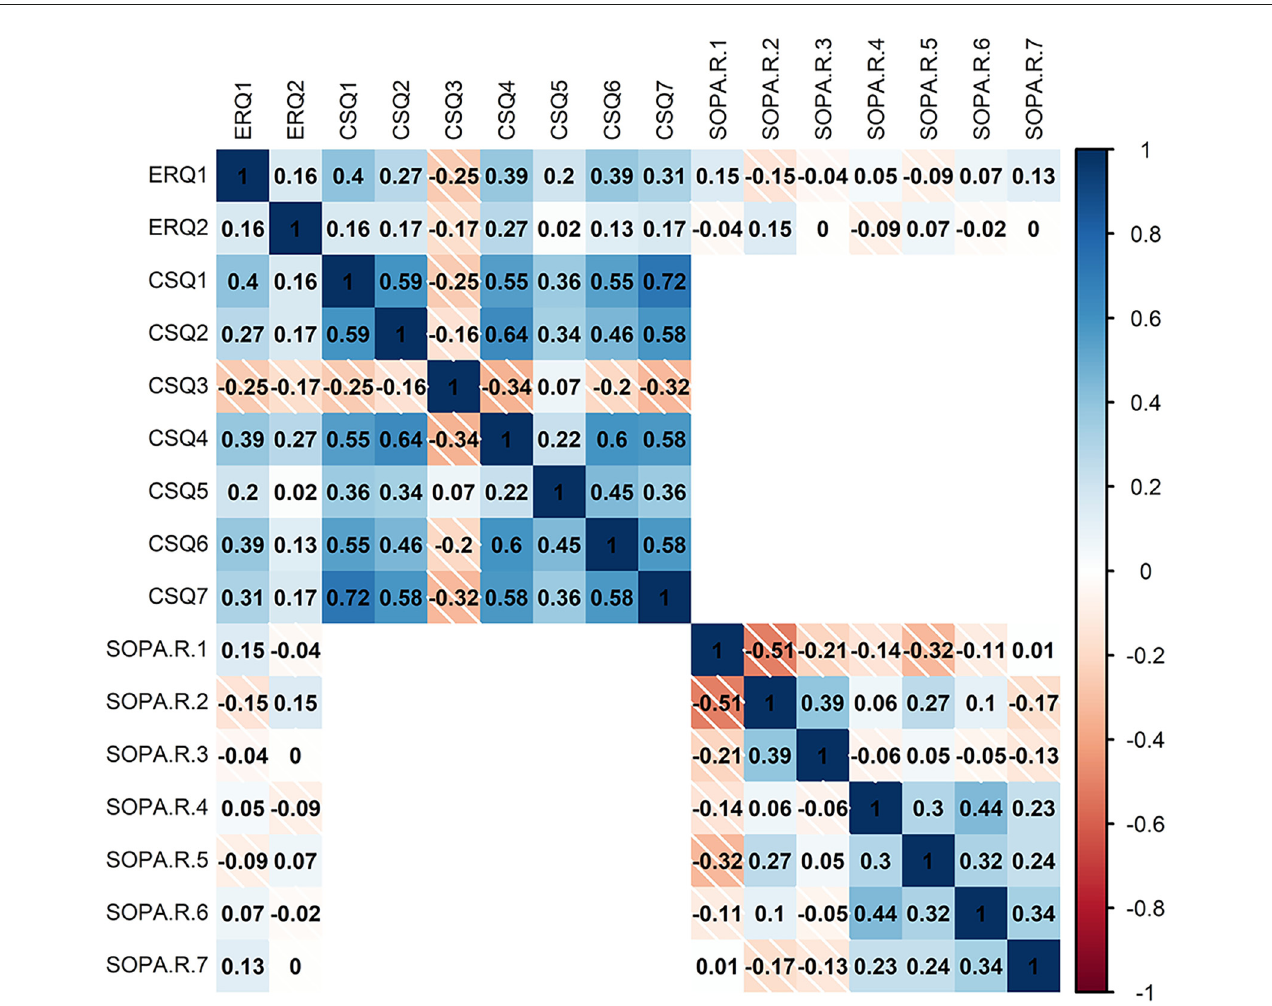
FIGURE1 Heatmap of Pearson correlations ( − 1:1 shown by color legend) for SOPA, survey of pain attitude; ERQ, emotion regulation questionnaire; and CSQ, coping strategies